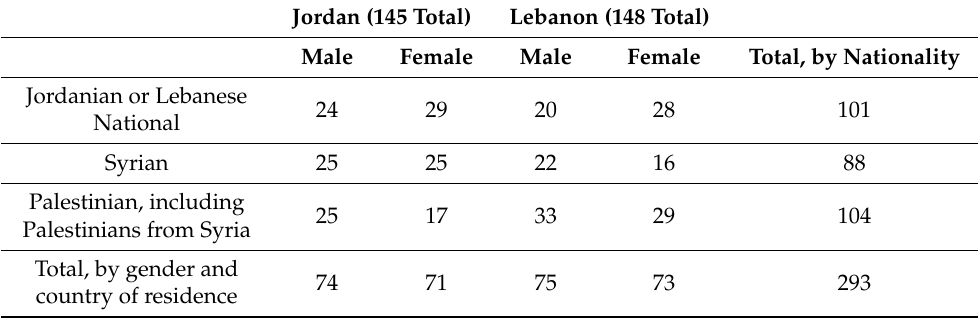
Table 1. Research participants and life history interviews, according to country and legal